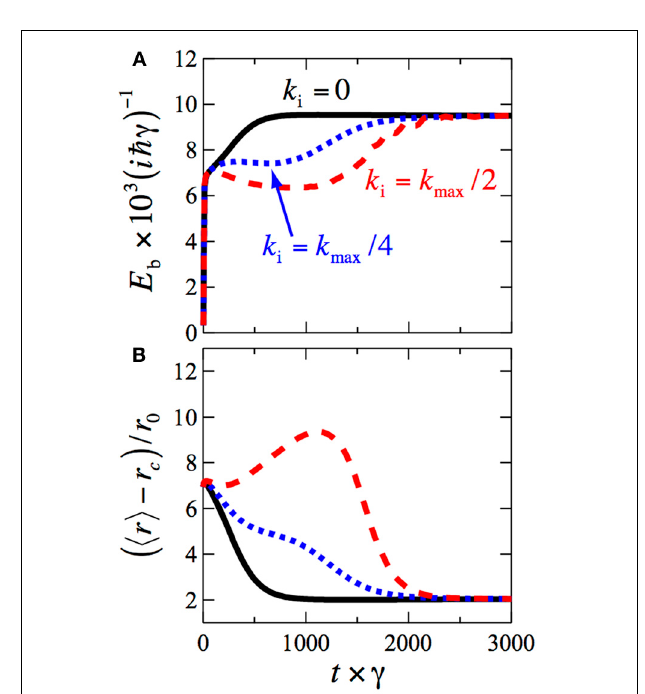
FIGURE 3 | Absolute values (blue solid lines) and real parts (red dotted lines) of the scattering wavefunctions at times (a) t = 0; (b) t = 1000 γ − 1 ; (c) t = 2000 γ − 1 ; and (d) t = 3000 γ − 1 . Pairs of columns show the